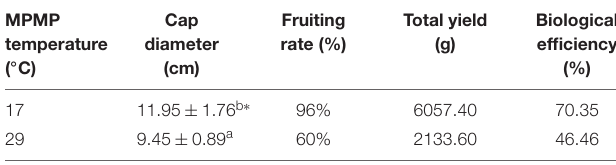
TABLE 2 | The biological properties of P. tuoliensis subjected to different temperatures of